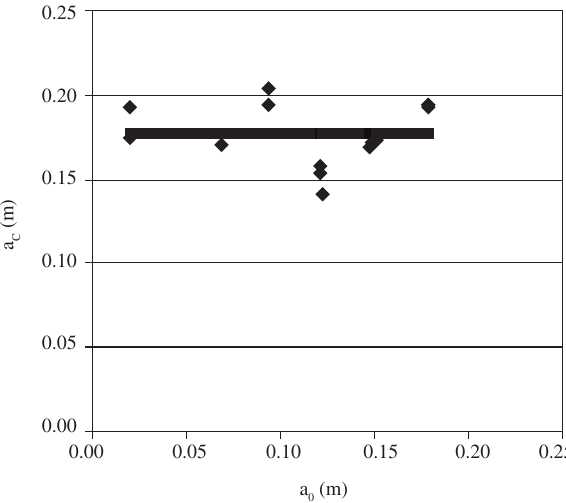
Figure 6. Graphic representation of the calculation of work of fracture, γ based on the measurement of the area under the P-d curve.